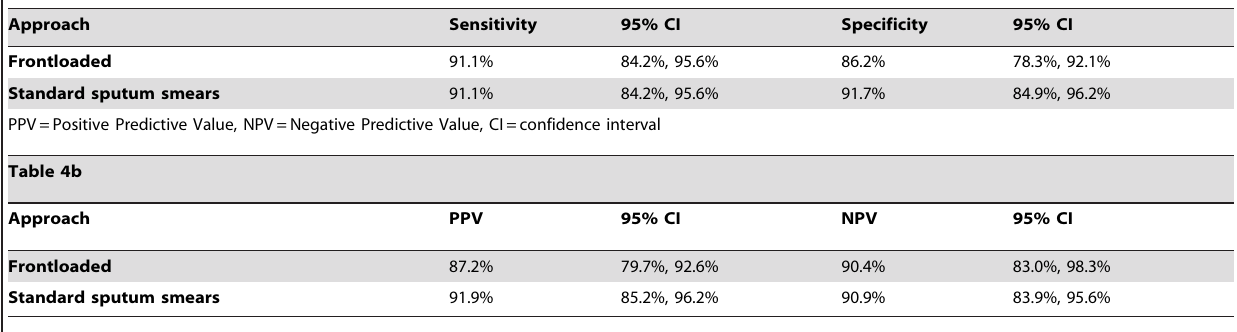
(Table 2). Detailed information on the performance of the three samples by HIV status is shown in Table 3.